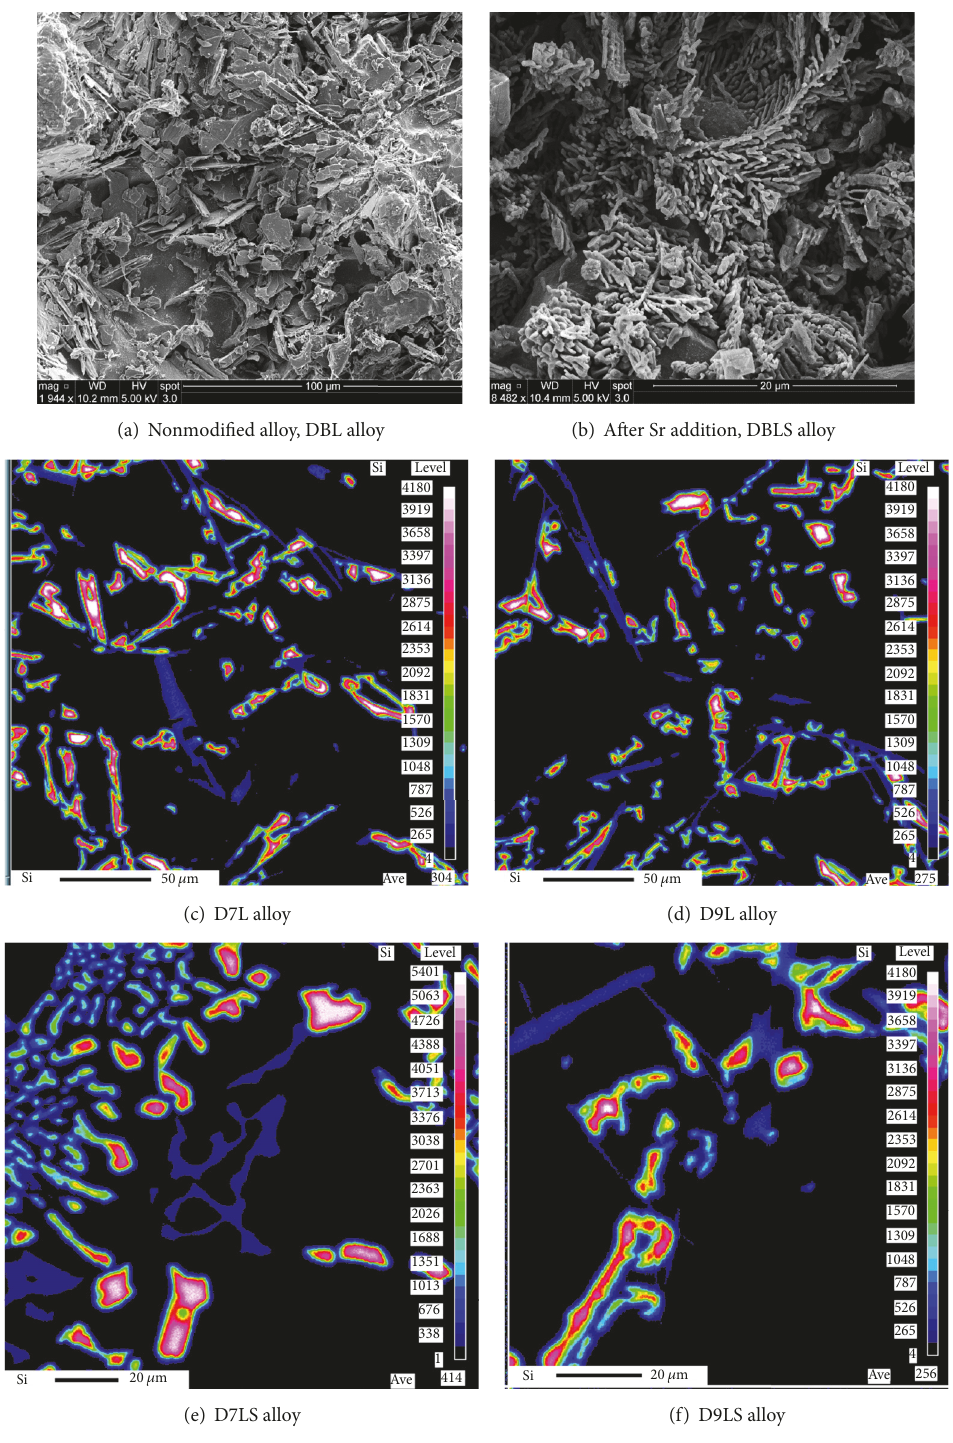
Figure 9: Examples of the eutectic Si particle size and distribution after different melt treatments/additions in A356 alloy samples obtained from the variable angle mold (large)